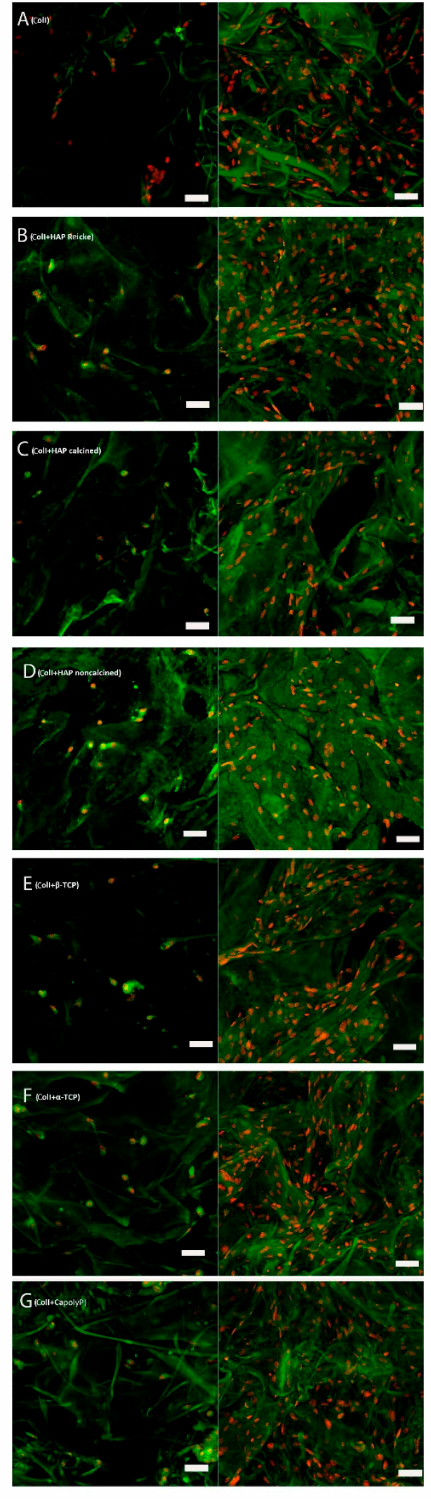
Figure 7. Representative images from confocal microscope on days 1 (left column) and 14 (right column). In red, cell nuclei visualized by propidium iodide; in green, cytoplasm stained by DiOC 6 (3) and scaffold autofluorescence. Scale bar 50 µ m. Cells seeded on: Coll ( A ), ColI+HAP Reicke ( B ), ColI+HAP calcined ( C ), ColI+HAP noncalcined ( D ), ColI+ β -TCP ( E ), ColI+ α -TCP ( F ) and ColI+CapolyP ( G